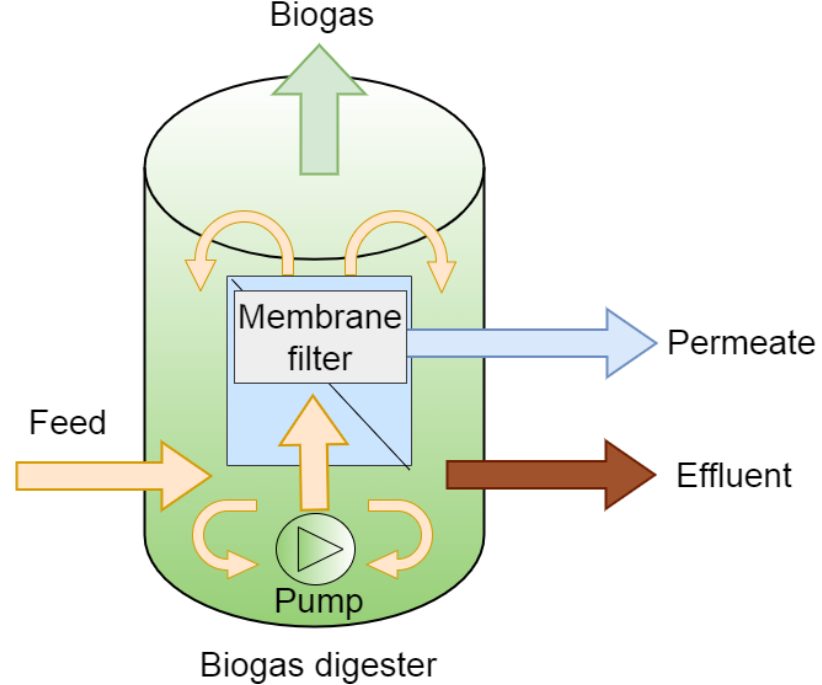
Figure 3. Scheme of an integrated AnMBR.